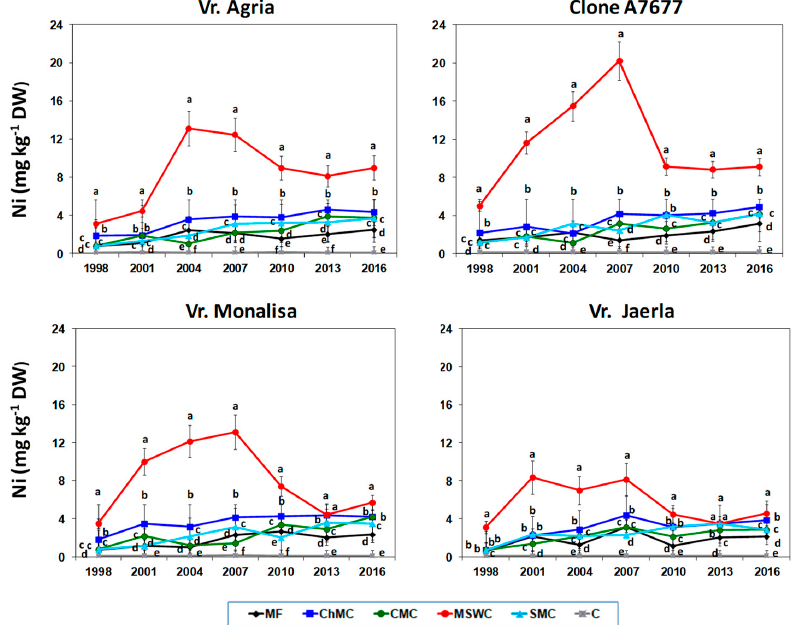
Figure 13. Evolution of nickel content (mg kg − 1 DW) in potato tubers of the Agria, Monalisa, Jaerla and clone A7677 varieties (1998–2016) versus the application of compost from different organic amendments. The means with different lowercase letters within each season indicate significant differences between the treatments ( p < 0.001). Bars stands for standard deviations. MF: mineral fertilizer; ChMC: chicken manure compost; CMC: cow manure compost; MSWC: municipal solid waste compost; SMC: sheep manure compost; C: control.